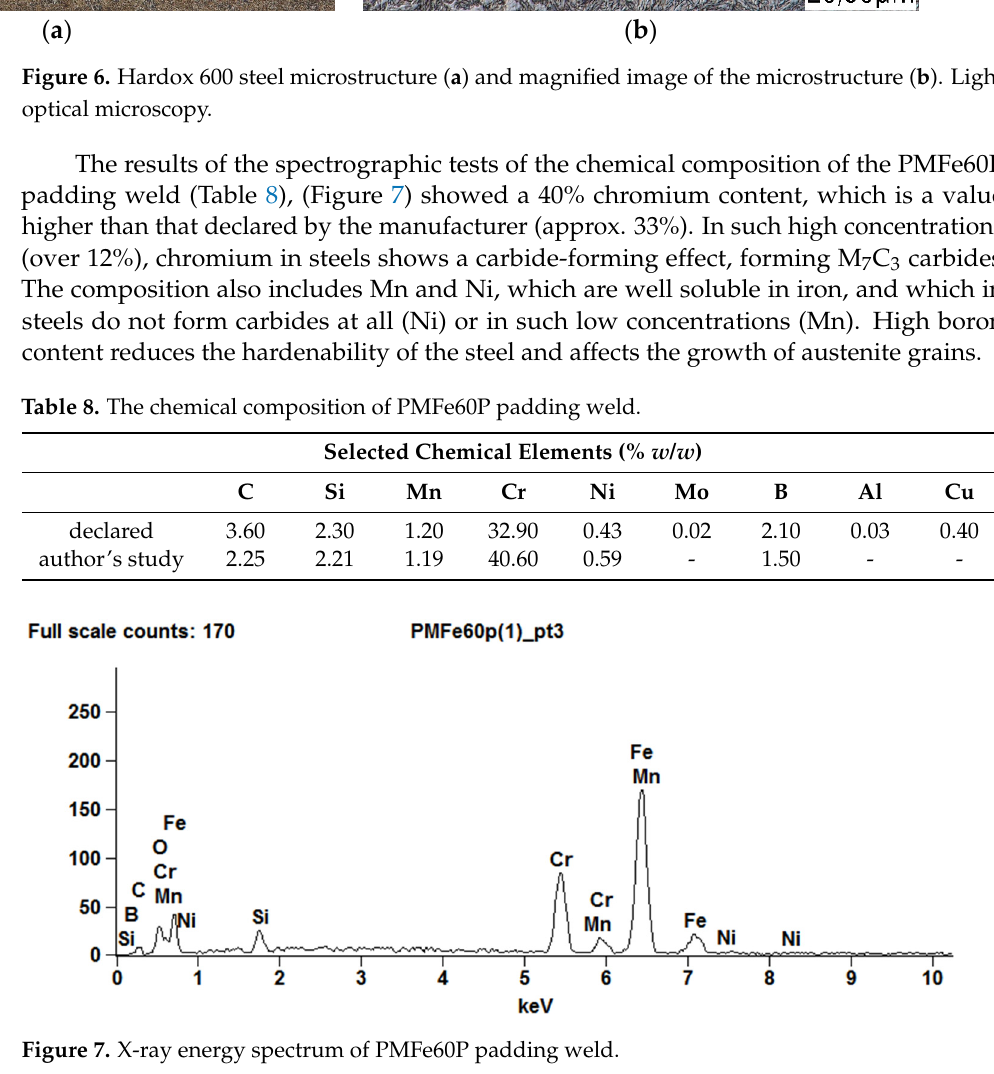
Due to the high contents of Cr and Fe, after hardfacing, a microstructure of PMFe60P layer, consisting of alloy ferrite as well as M 7 C 3 and MC carbides, was obtained. In the fusion penetration zone of the PMFe60P hardfaced layer, an alloy ferrite microstructure was identified, while in the padding weld, primary carbide precipitates (Fe, Cr) 7 C 3 with a